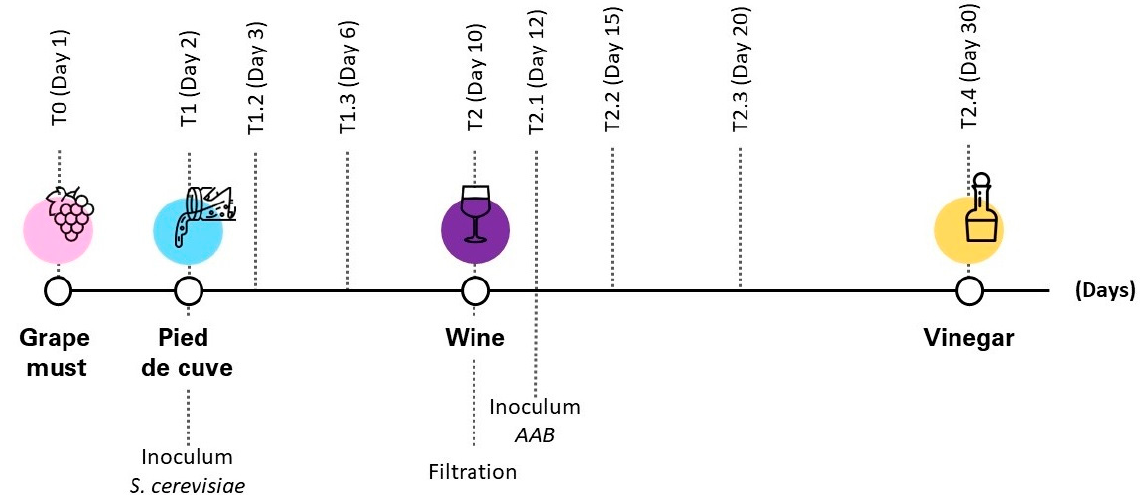
Figure 1. Flow sheet wine vinegar production.